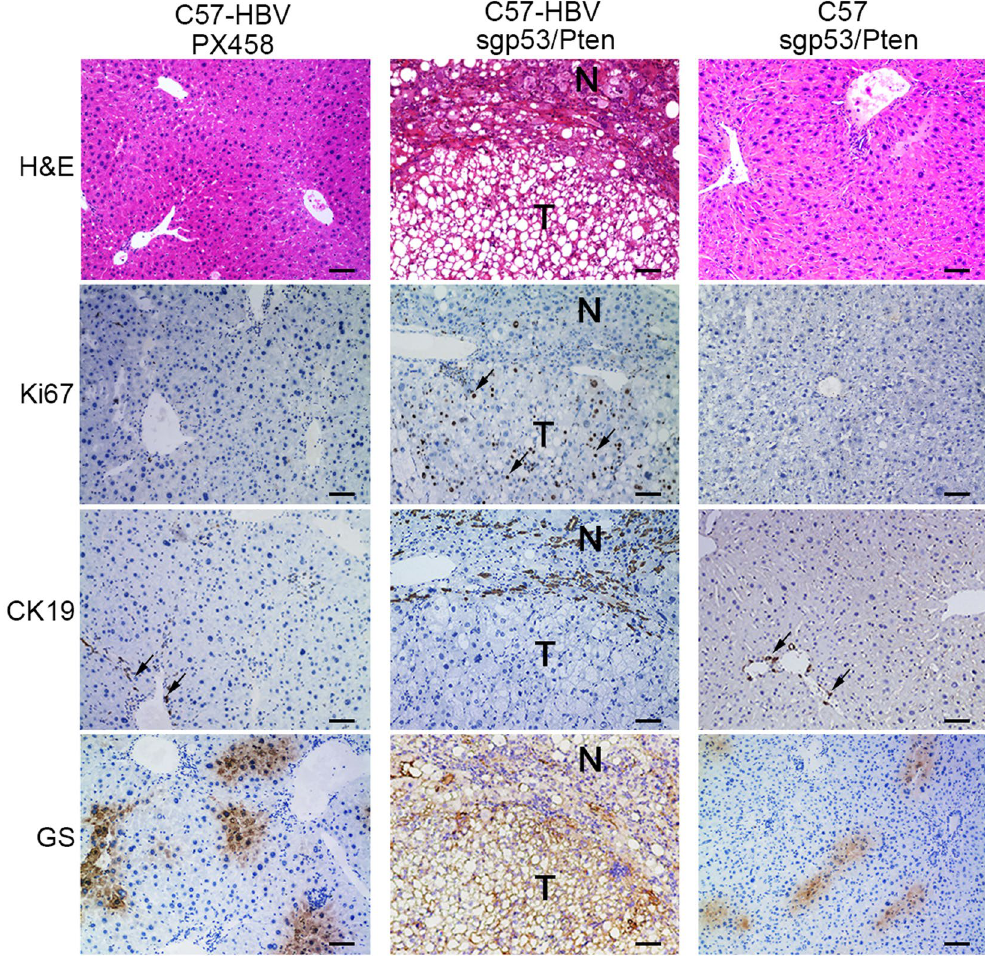
Figure 4. Histological and pathological determination. H&E staining, Ki67, CK19 and GS IHC staining of the liver sections in the three groups. For Ki67 and CK19 IHC staining the represent positive staining cells were showed by arrows. T, tumor; N, non-tumor. The scale bar is 200 μ